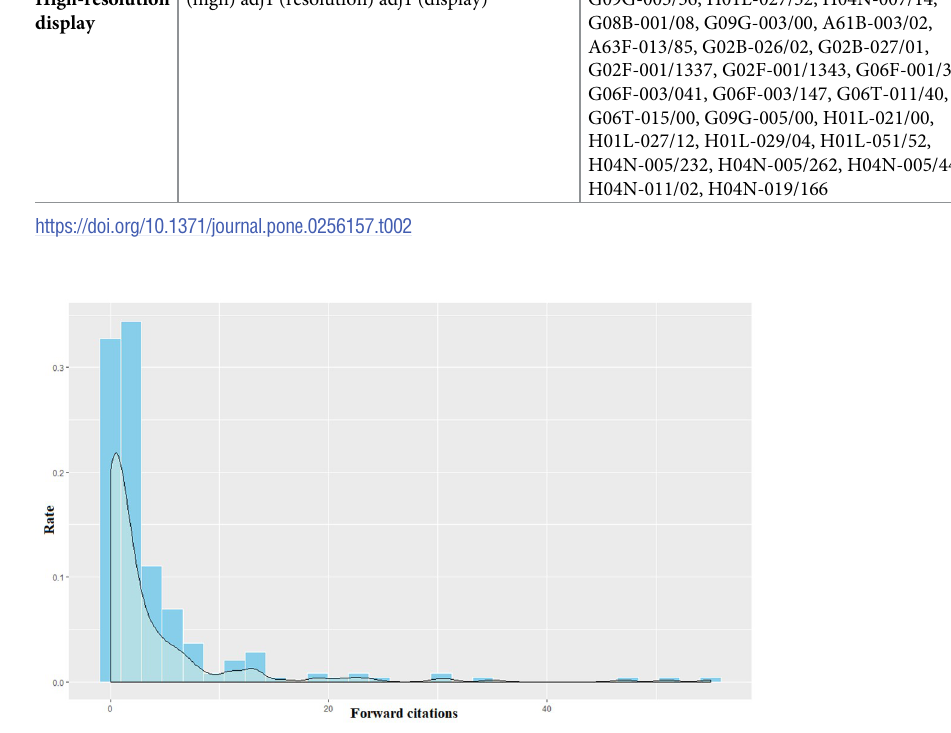
Fig 2. Distribution of forward citations of